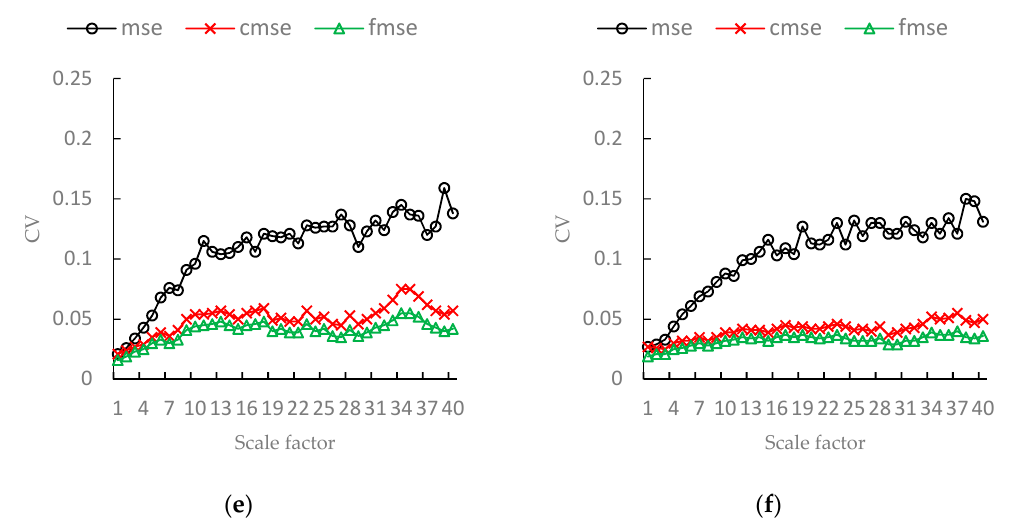
Figure 13. The CVs of MSE, CMSE, FMSE values on bearing vibration data (1730 rpm, 7 mils). ( a ) Normal state; ( b ) Outer race fault (3 o’clock position); ( c ) Outer race fault (6 o’clock position); ( d ) Outer race fault (12 o’clock position); ( e ) Ball fault; ( f ) Inner race fault. Table 2. The CVs with different entropy and scale factor of vibration signal.